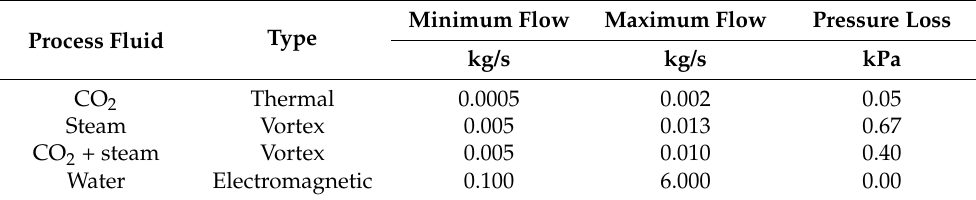
Table 9. Selected parameters of chosen solutions.